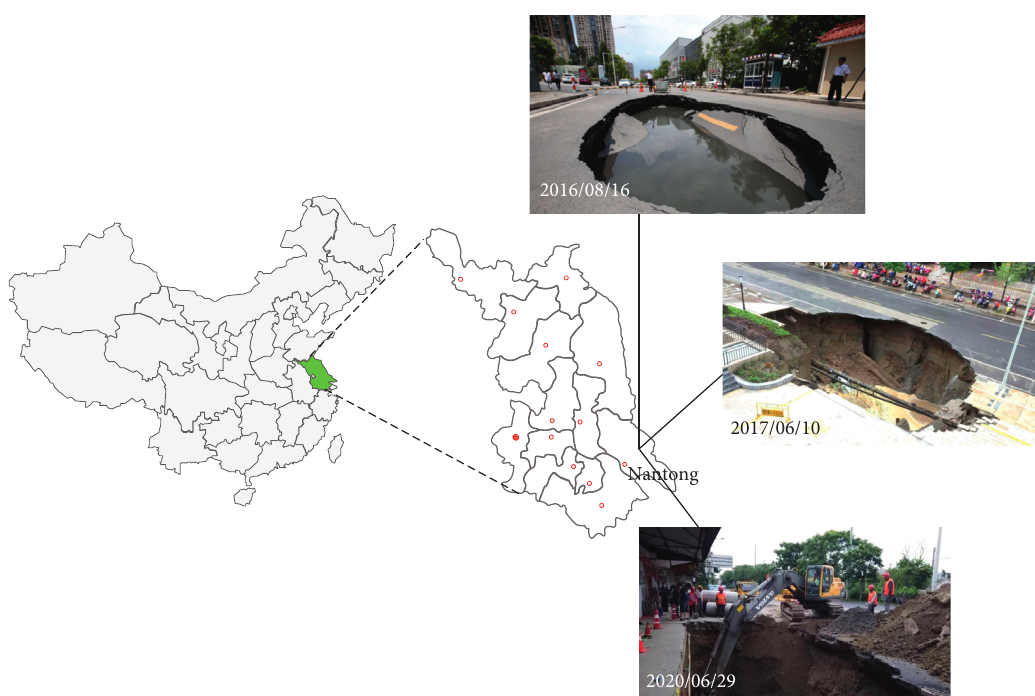
Figure 1: Pavement subsidence in Nantong city in recent